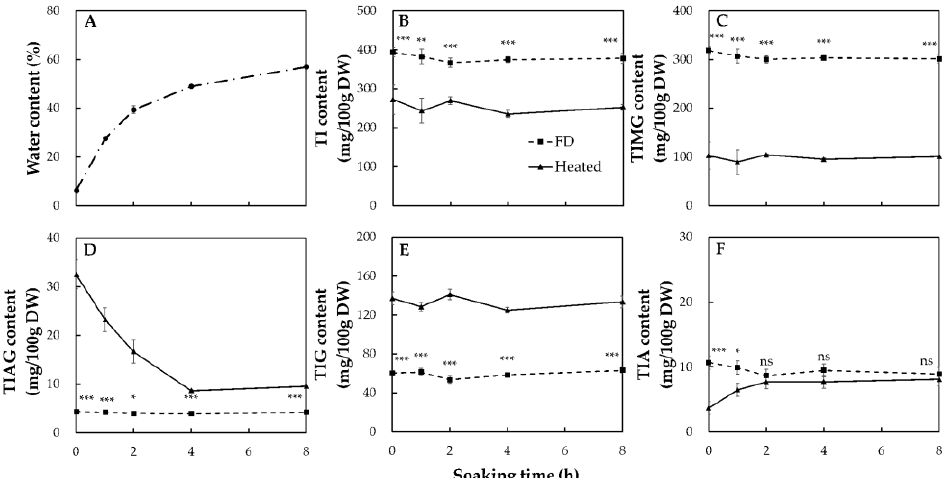
Figure 4. Water content of mature seeds during serial soaking ( A ), and isoflavone contents in soaked seeds after freeze-drying (FD) and dry-heating ( B – F ). ( A ), water content; ( B ), total isoflavone (TI); ( C ), total isoflavone malonylglycosides (TIMG); ( D ), total isoflavone acetylglycosides (TIAG); ( E ), total isoflavone β -glycosides; ( F ), total isoflavone aglycones. Data are shown as mean with standard error ( n = 3). Asterisks indicate statistically significant differences (*, p < 0.05; **, p < 0.01; ***, p < 0.001; ns indicates no